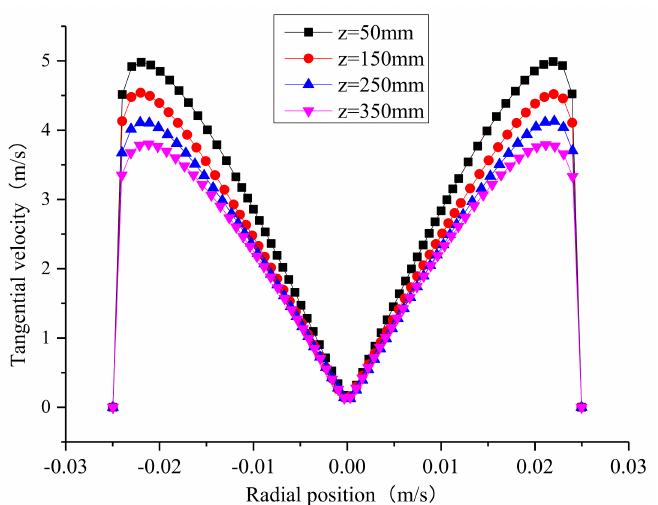
Figure 11. Radial distribution curves of tangential velocity in different cross